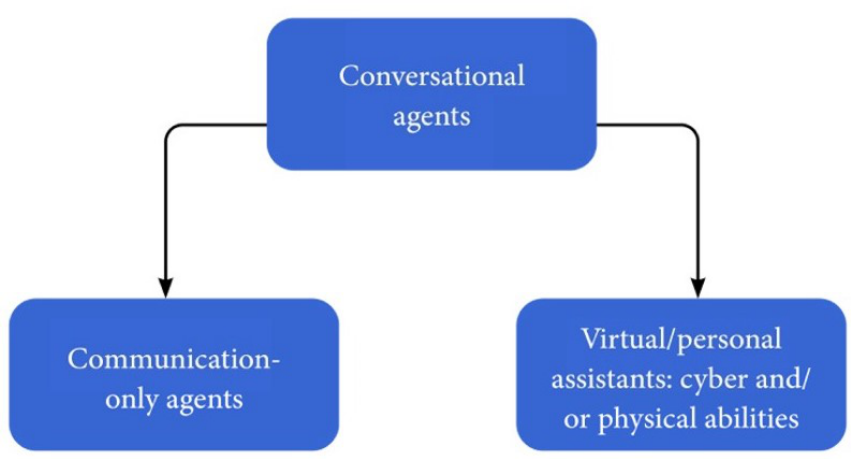
Figure 2. Conversational-agent classification according to action capabilities.